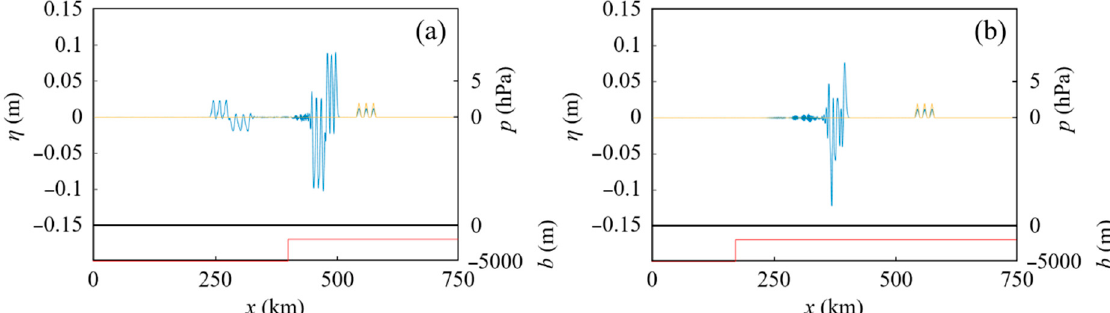
Figure 6. Water surface profiles at t = 2100 s for different offshore end positions of the shallower area, x on , in Case D, in which x 1 = 55 km and δ = 5 km in Figure 1; h on = 2000 m in Figure 2a. The blue, orange, and red lines indicate the water surface displacement η , atmospheric pressure p , and seabed position b , respectively. ( a ) x on = 400 km and ( b ) x on = 170 km in Figure 2a.